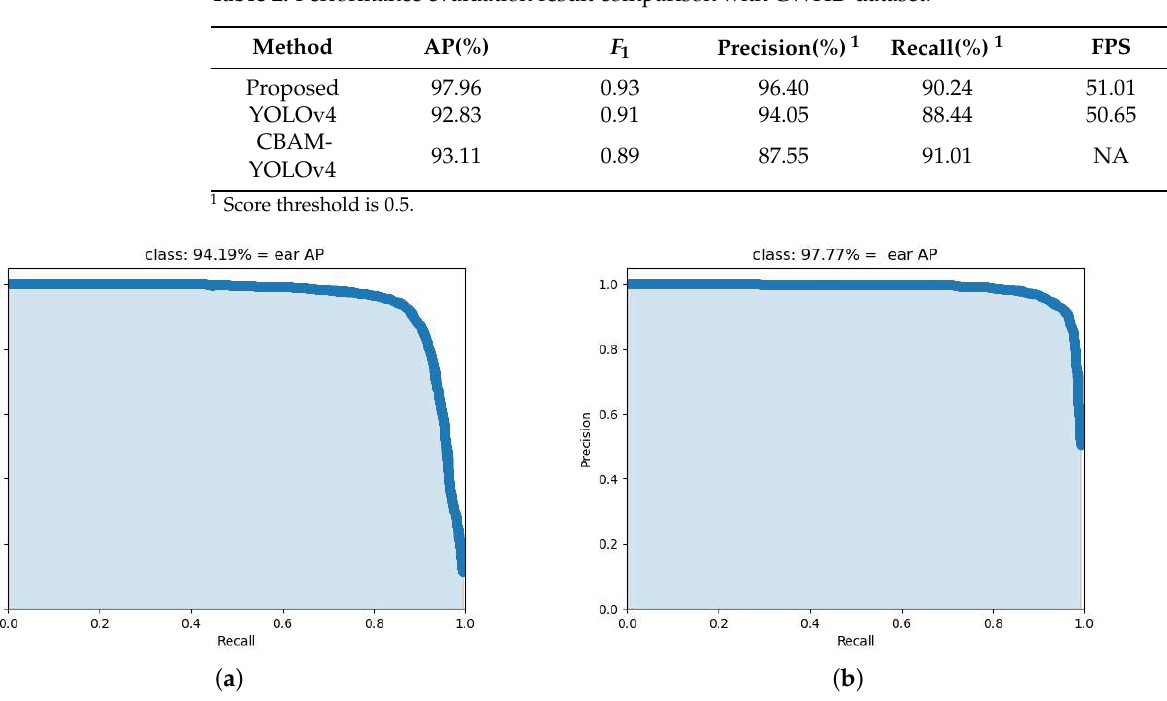
Figure 3. Precision–Recall curves for 2 datasets. ( a ) Precision–Recall curve based on HRED dataset. ( b ) Precision–Recall curve based on GWHD